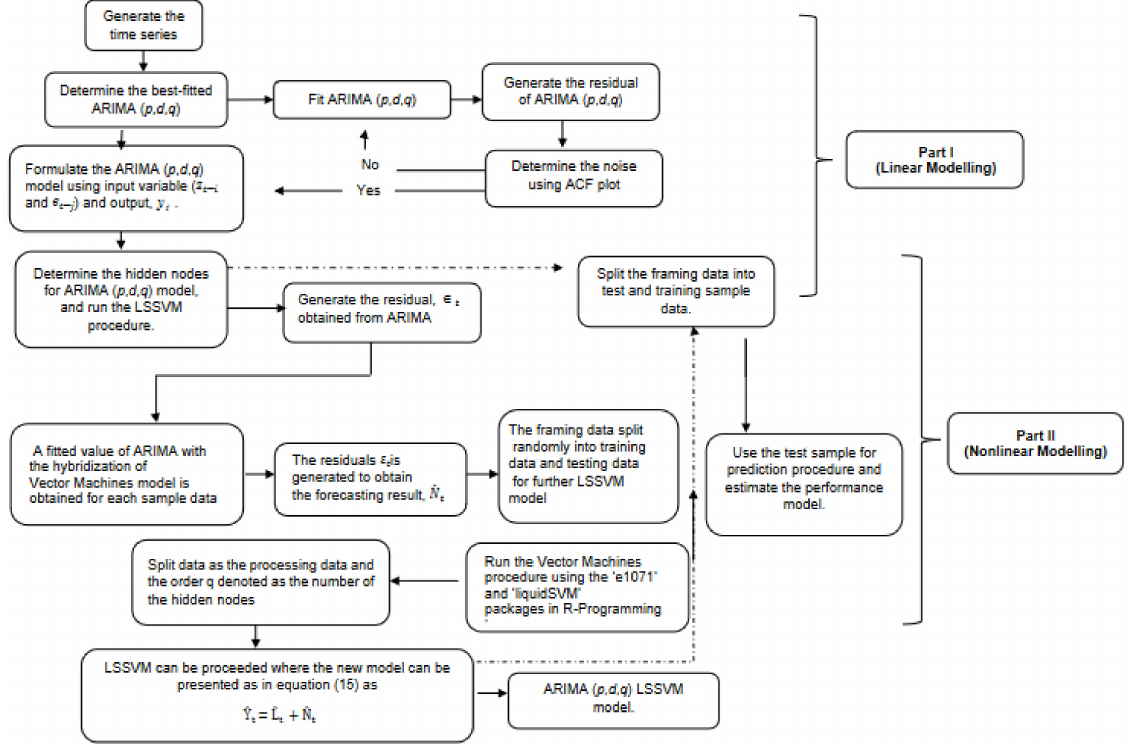
Figure 1. Flowchart process for hybrid ARIMA-LSSVM